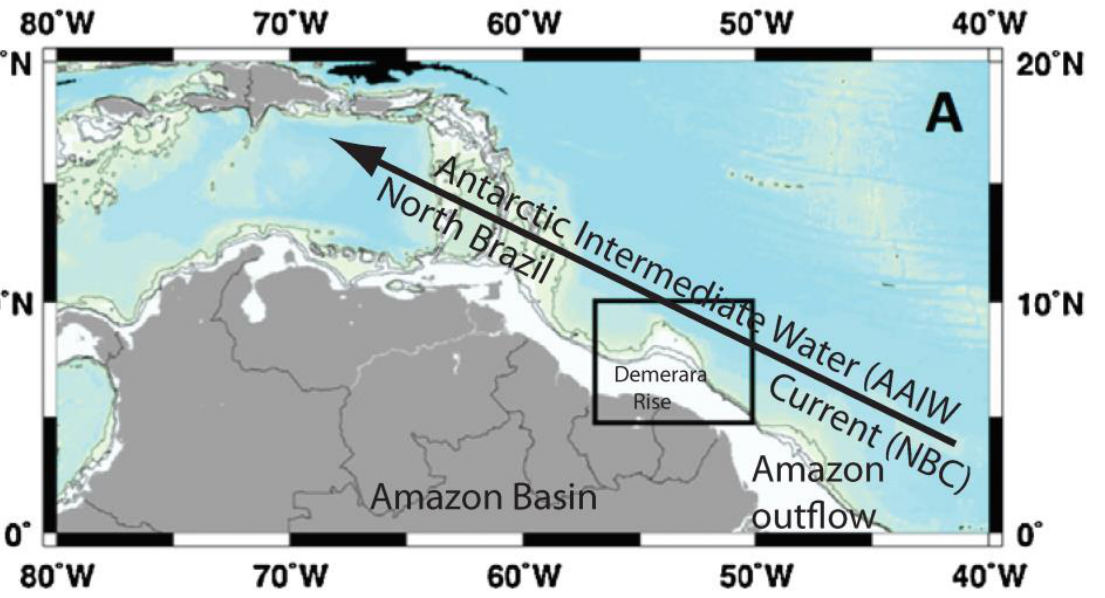
Figure 1. ( A ) Map of the northeastern continental margin of South America showing the Demerara Rise and general flow of the surface North Brazil Current. ( B ) Demerara Rise bathymetry and locations of our studied cores (stars). 2. Regional Ocean Circulation The ocean circulation pattern in the western Equatorial Atlantic Ocean is dominated by the Atlantic Meridional Overturning Circulation (AMOC) (Berger and Wefer, 1996; Schmitz and McCartney, 1993) [13,14]. This system brings warm water into the North Atlantic Ocean, where it is transformed into North Atlantic Deep Water (NADW), which then migrates to the South Atlantic Ocean (Metcalf and Stalcup, 1967; Kirchner et al., 2009)